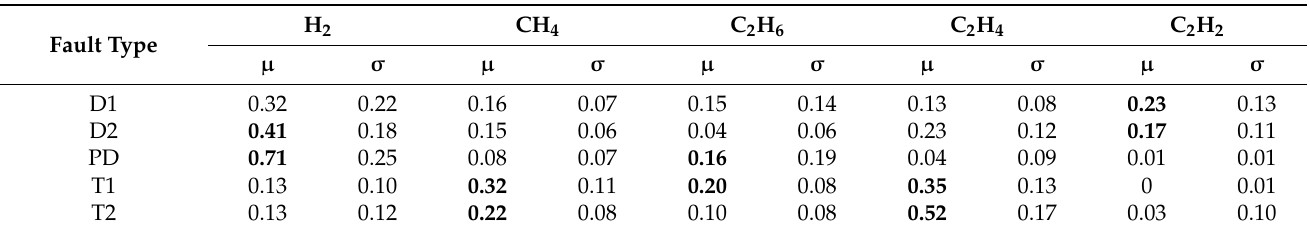
Table 2. Means ( µ ) and variances ( σ ) of DGA data evaluated using bootstrapping with 1000 repetitions (in percentages).